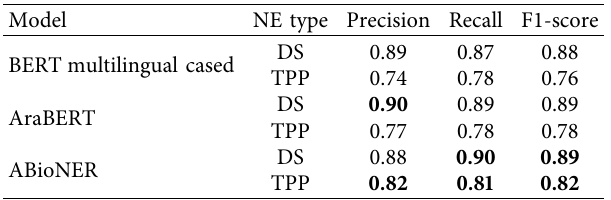
Table 2: NER detailed test results for ABioNER, AraBERT, and BERT multilingual cased models.